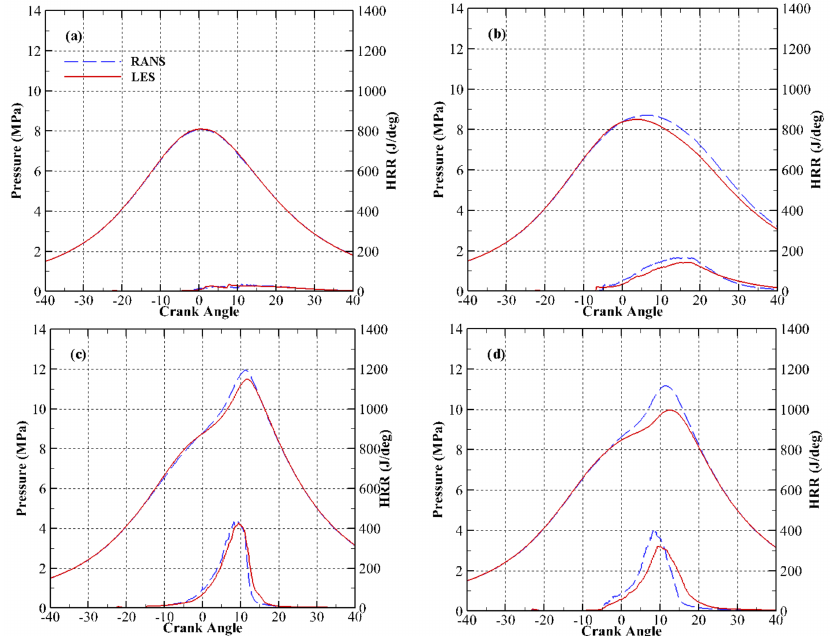
Figure 8. Comparison of LES and RANS model for cylinder pressure and HRR: ( a ) SOI2 = 0 ATDC; ( b ) SOI2 = − 15 ATDC, ( c ) SOI2= − 30 ATDC; ( d ) SOI2= − 45 ATDC.